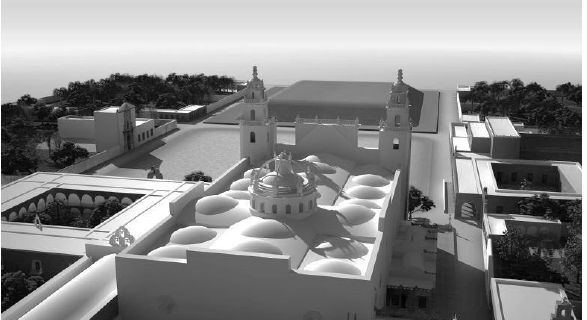
Figure 1. Main Square of Merida from the back side of